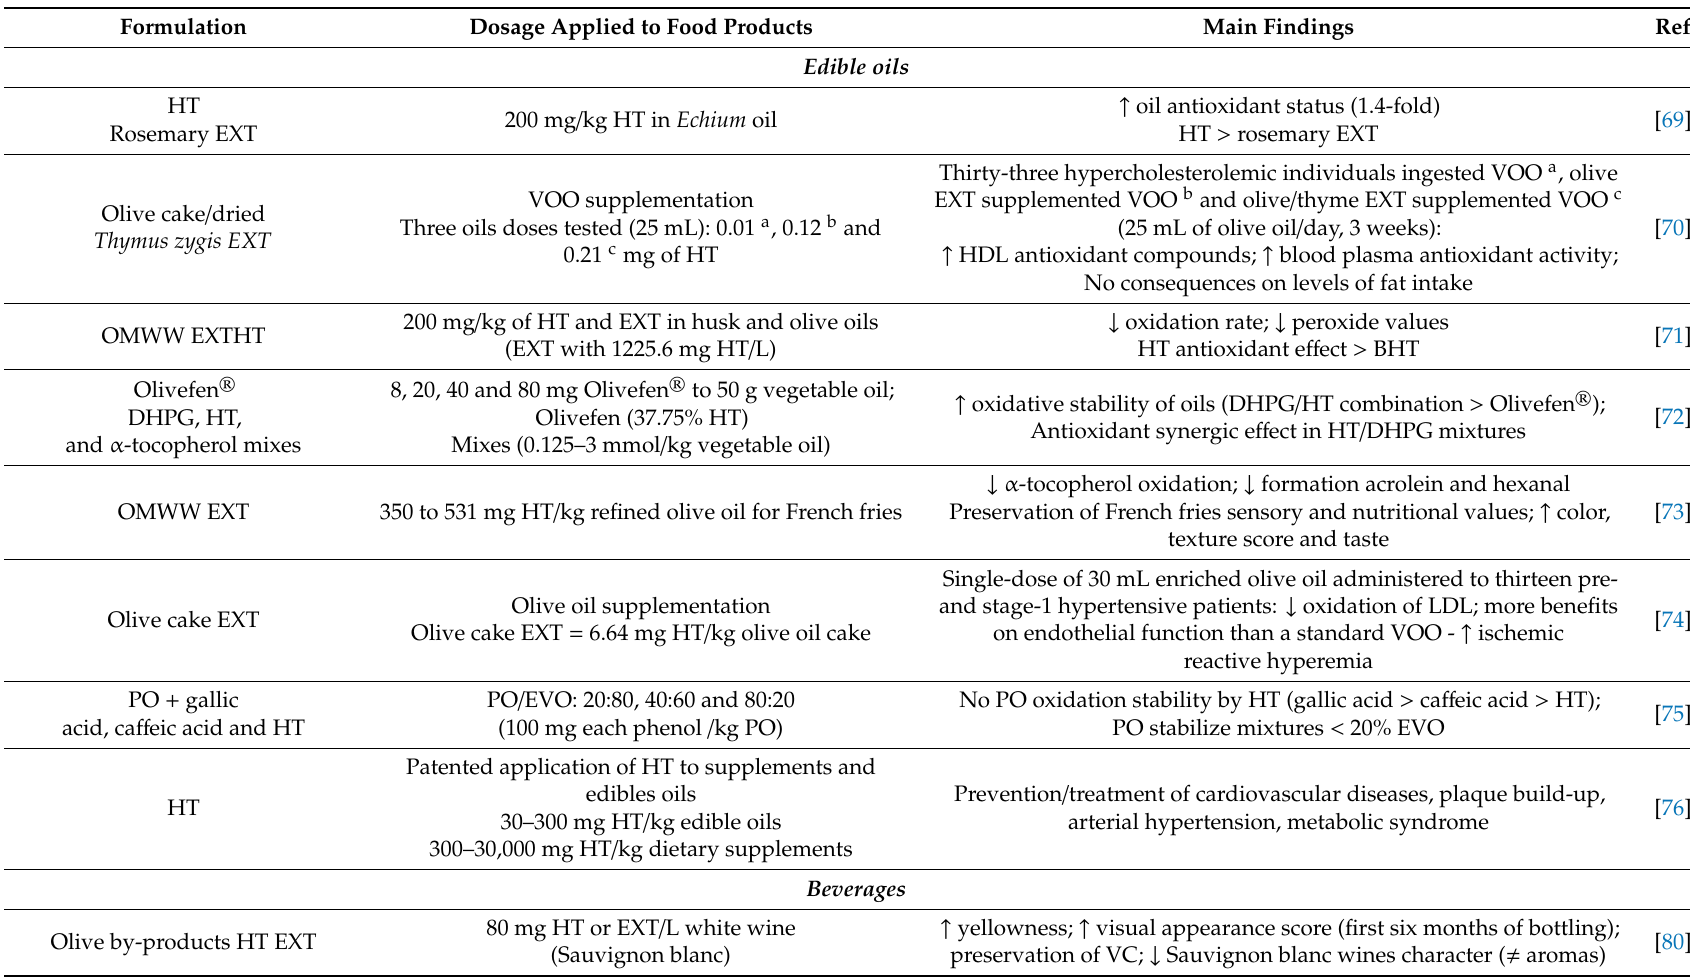
Table 1. Applicability of free or extract-based hydroxytyrosol (HT) on edible oils, beverages, and vegetable-based and bakery food